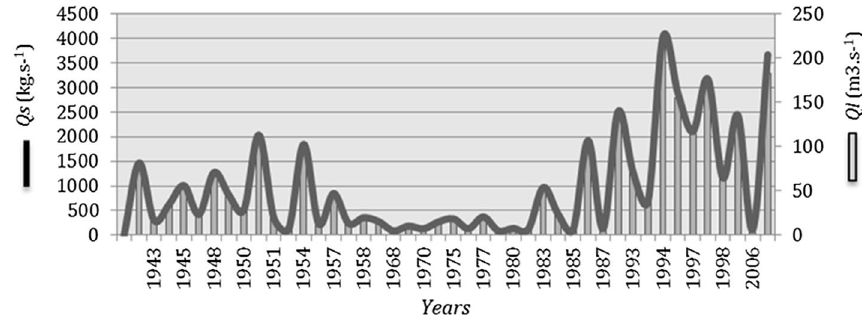
Fig. 5 The variability of solid flows and maximum liquid flows from 1942 to 2008 at the Sidi-bel-Abbes station